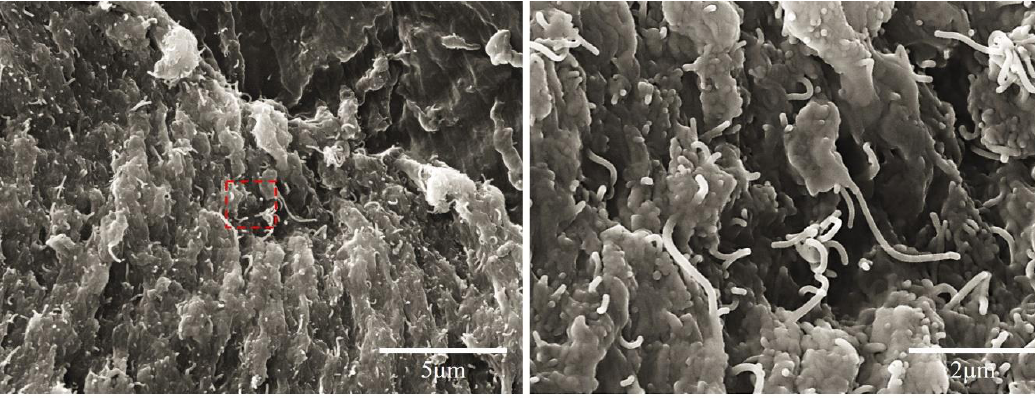
Figure 2. SEM images of 7 wt.% carbon nanotube modified polyurethane (CNT/PU) coatings (left) and enlargement of the red section (right).